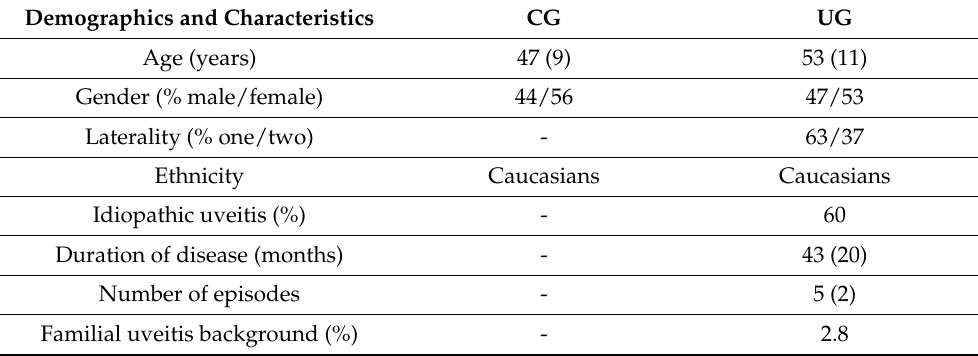
Table 3. Participant